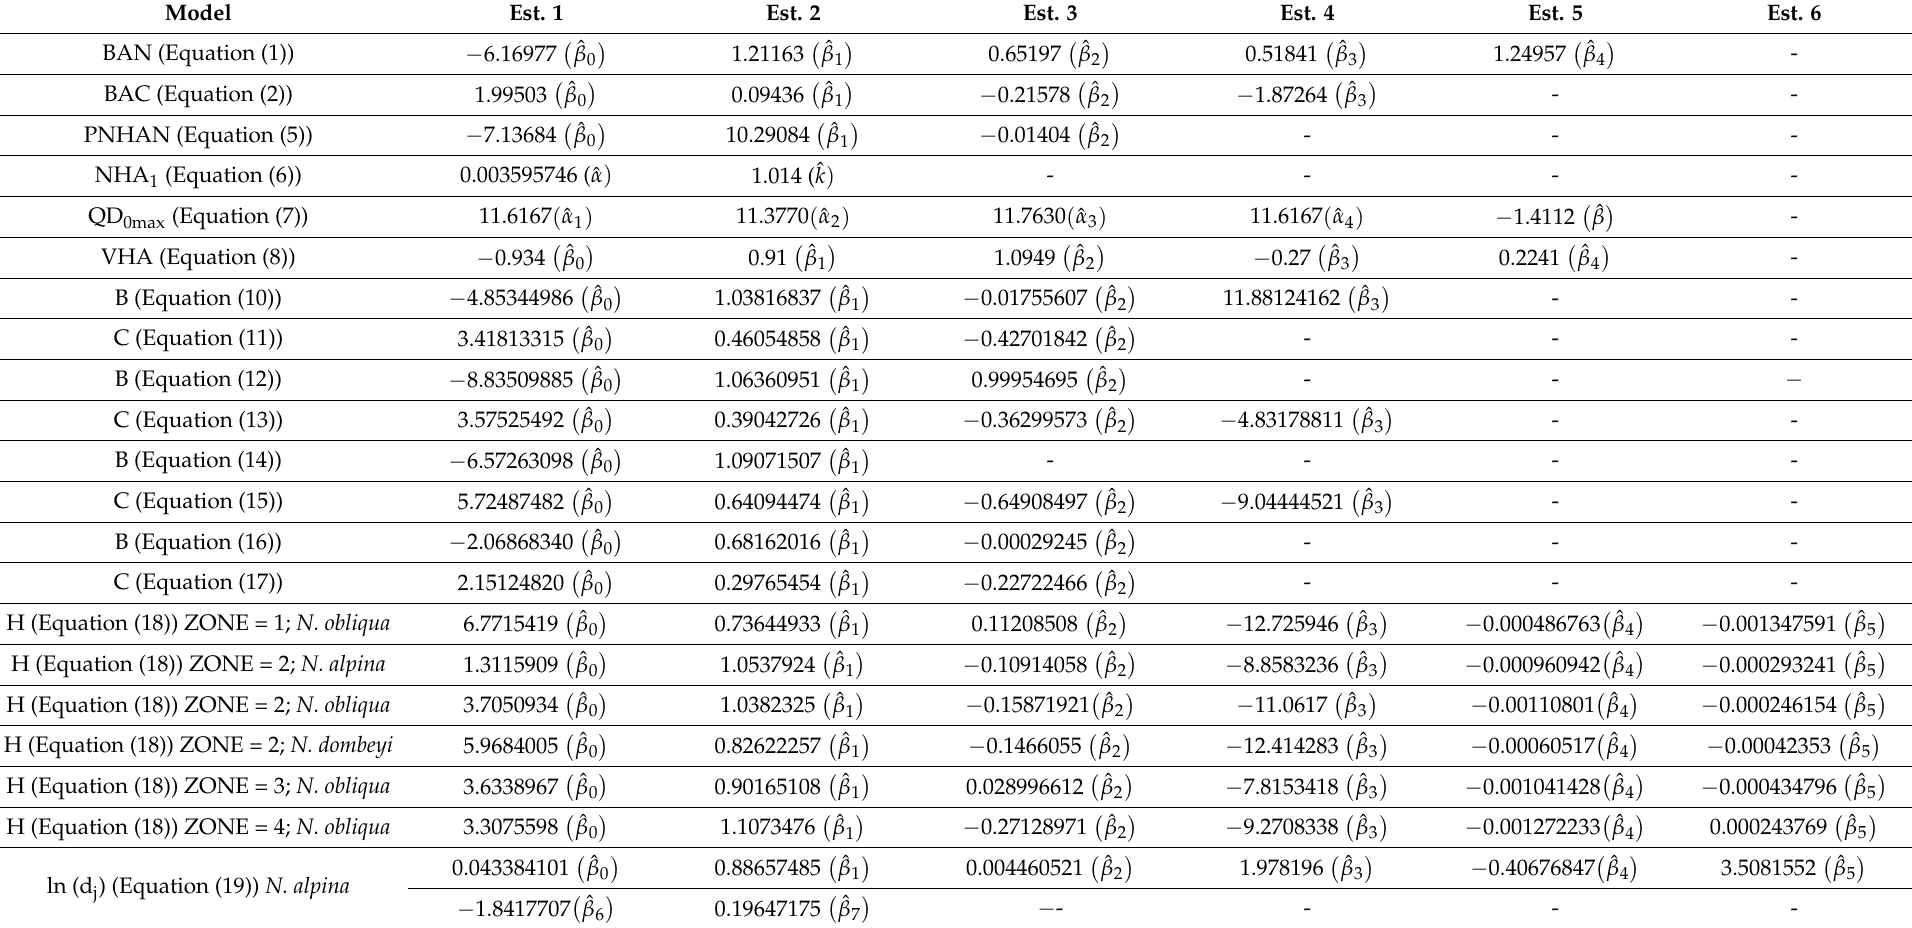
Table A1. Parameter estimates of models used in the